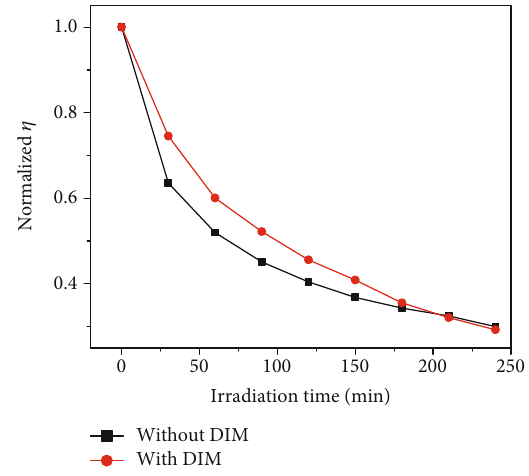
Figure 6: Normalized η of the PCDTBT:PC processed without and with 3% DIM as a function of irradiation (100mW/cm 2 ) time at ambient